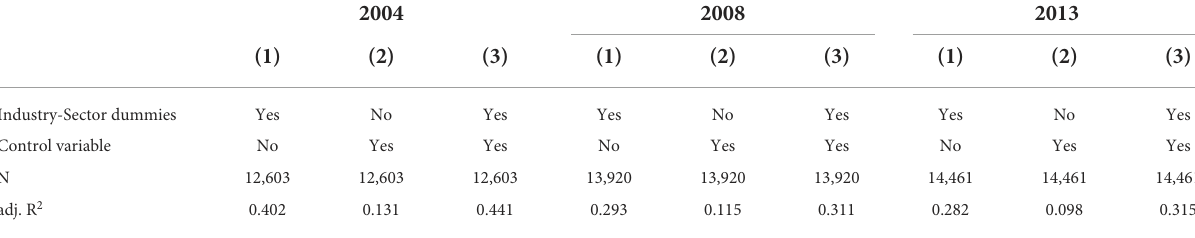
TABLE 1 Explanatory power of wage equations (Dep. Variable: log yearly